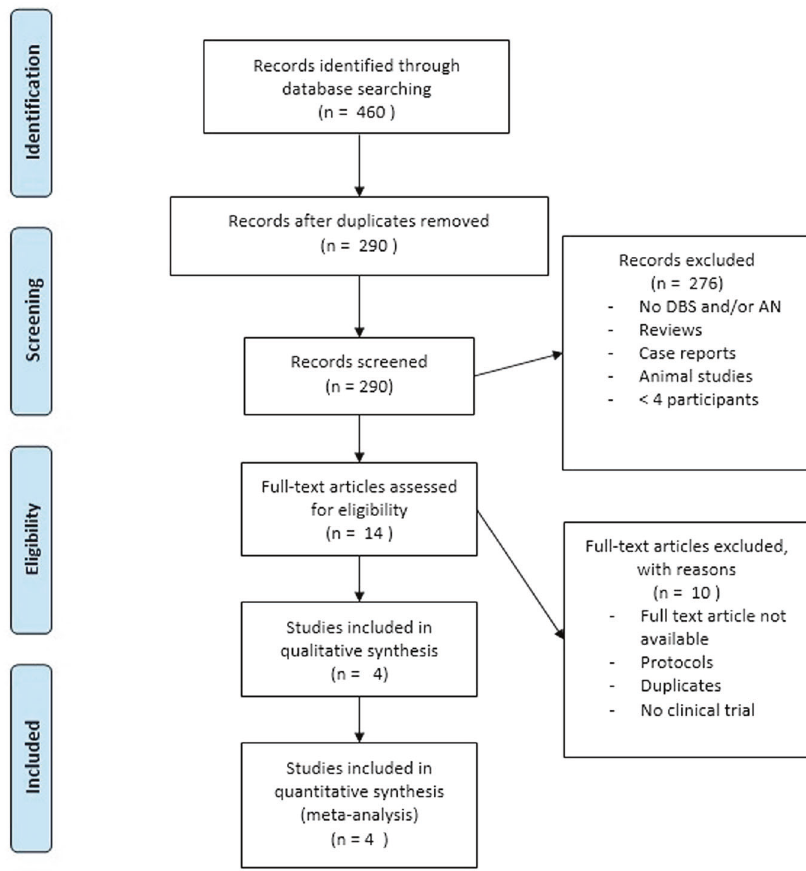
Fig. 1 Prisma fl ow diagram for included